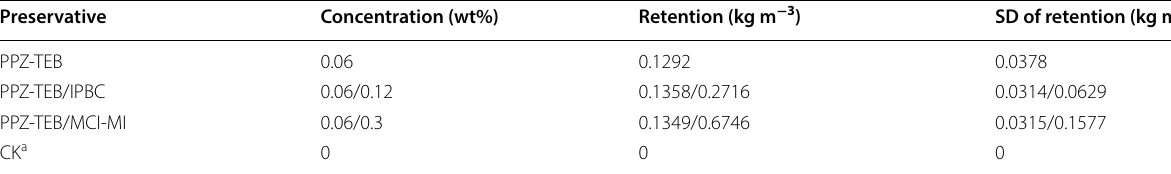
Table 1 Concentration and retention of preservatives